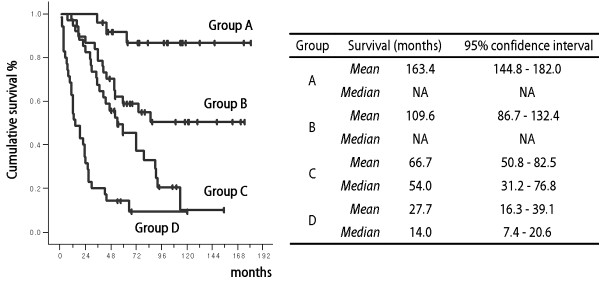
Survival plot of the risk groups defined in Table 3. Kaplan-Meyer analysis and the log-rank test revealed significant differences among the groups (p = 0.00).